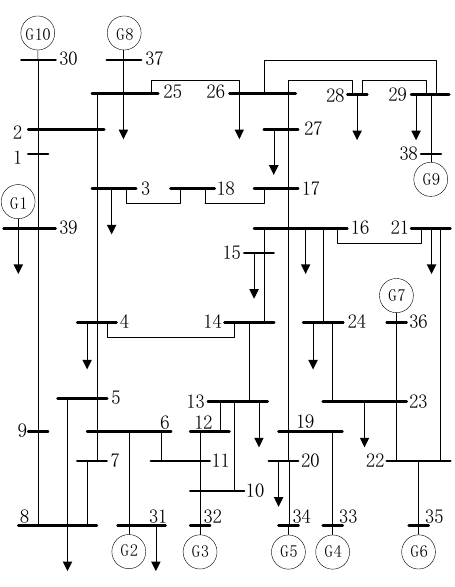
Figure 4. The New England power system.